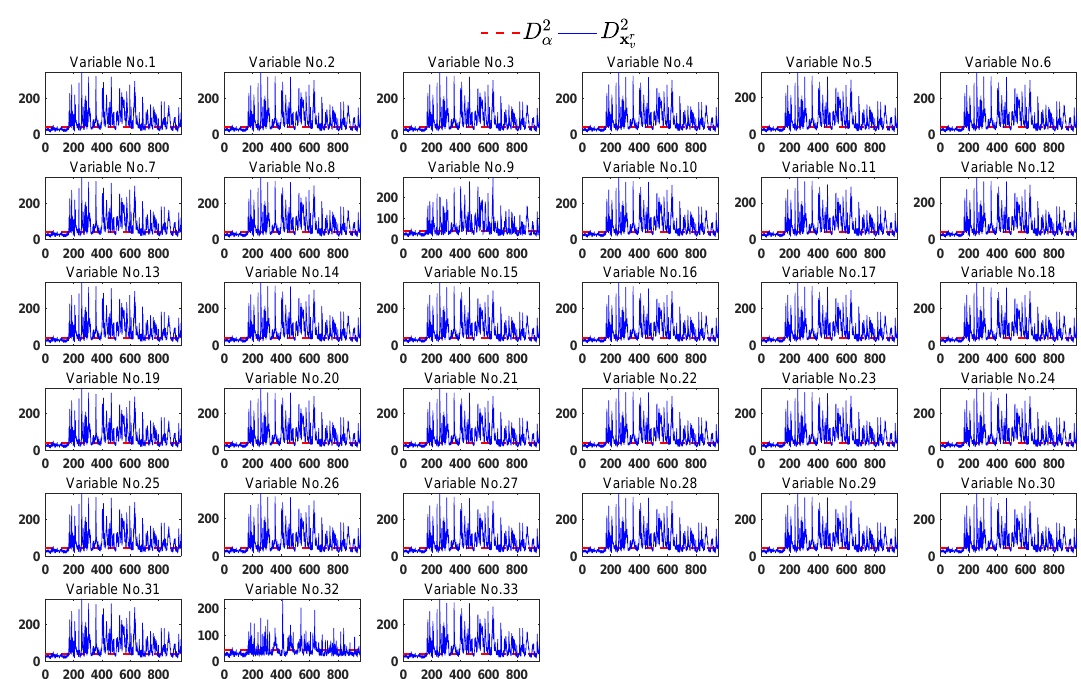
Figure 17. The fault detection results of reconstructed samples by estimating and replacing each variable for fault 11 of TE.